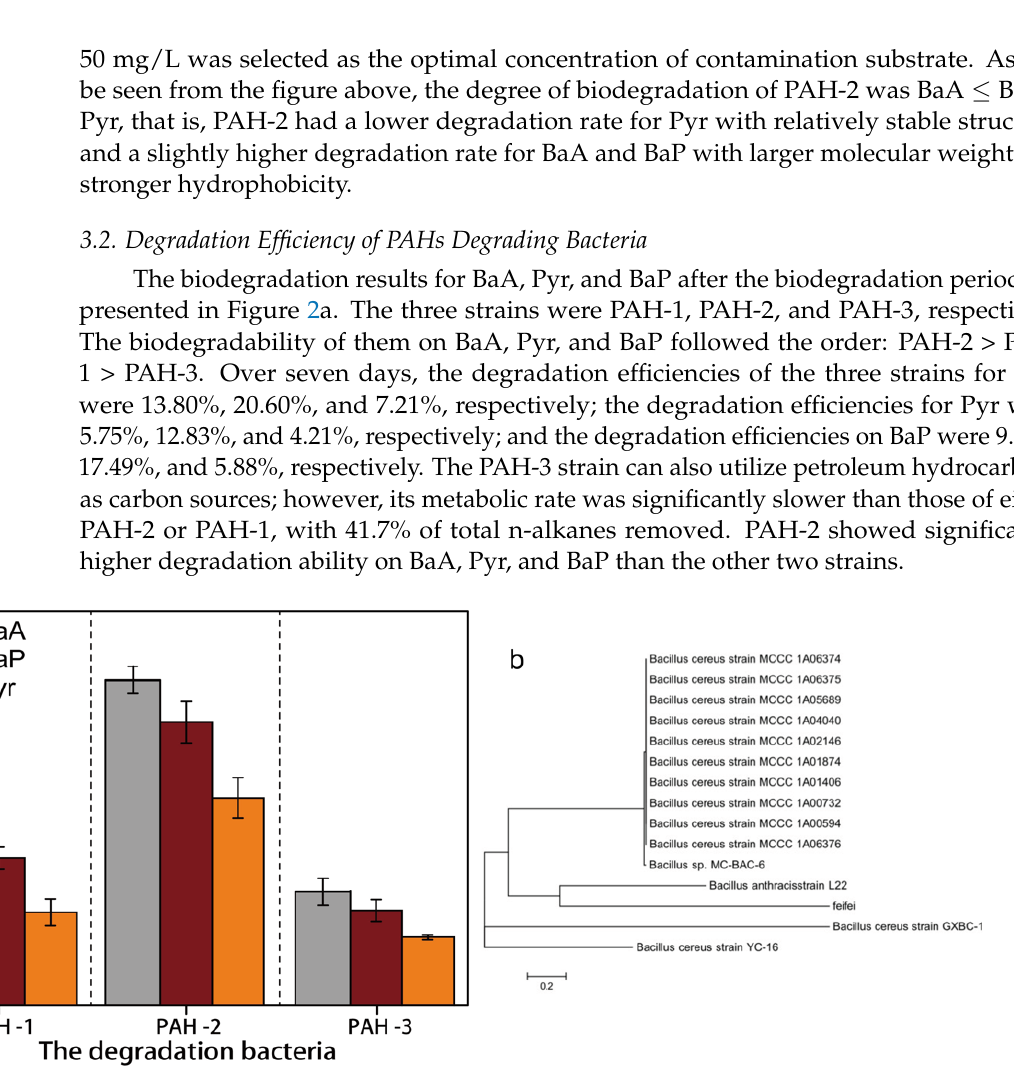
Figure 2. ( a ) The degradation of BaA, Pyr, and BaP by PAH degradation bacteria after seven days. Each degradation experiment was repeated three times to ensure repeatability and accuracy of the data. ( b ) Phylogenetic tree of PAH degrading Bacillus